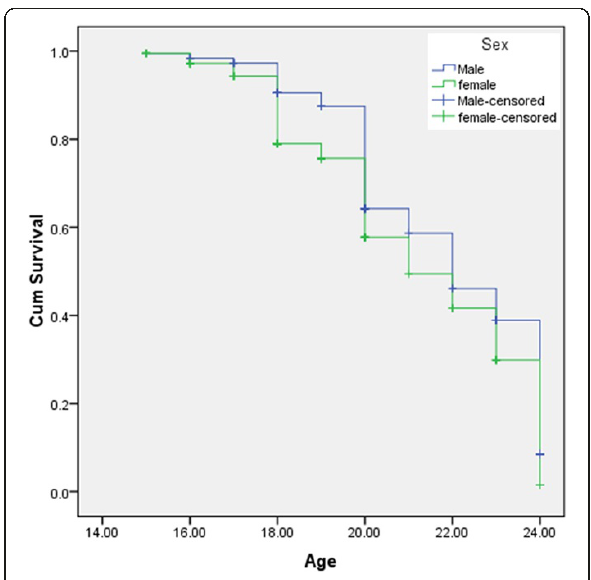
Figure 1 Kaplan-Meier indicating age at sexual initiation among male and female youths in Gamo-Gofa, South West Ethiopia (Log Rank chi-square = 6.85, p-value = 0.009).